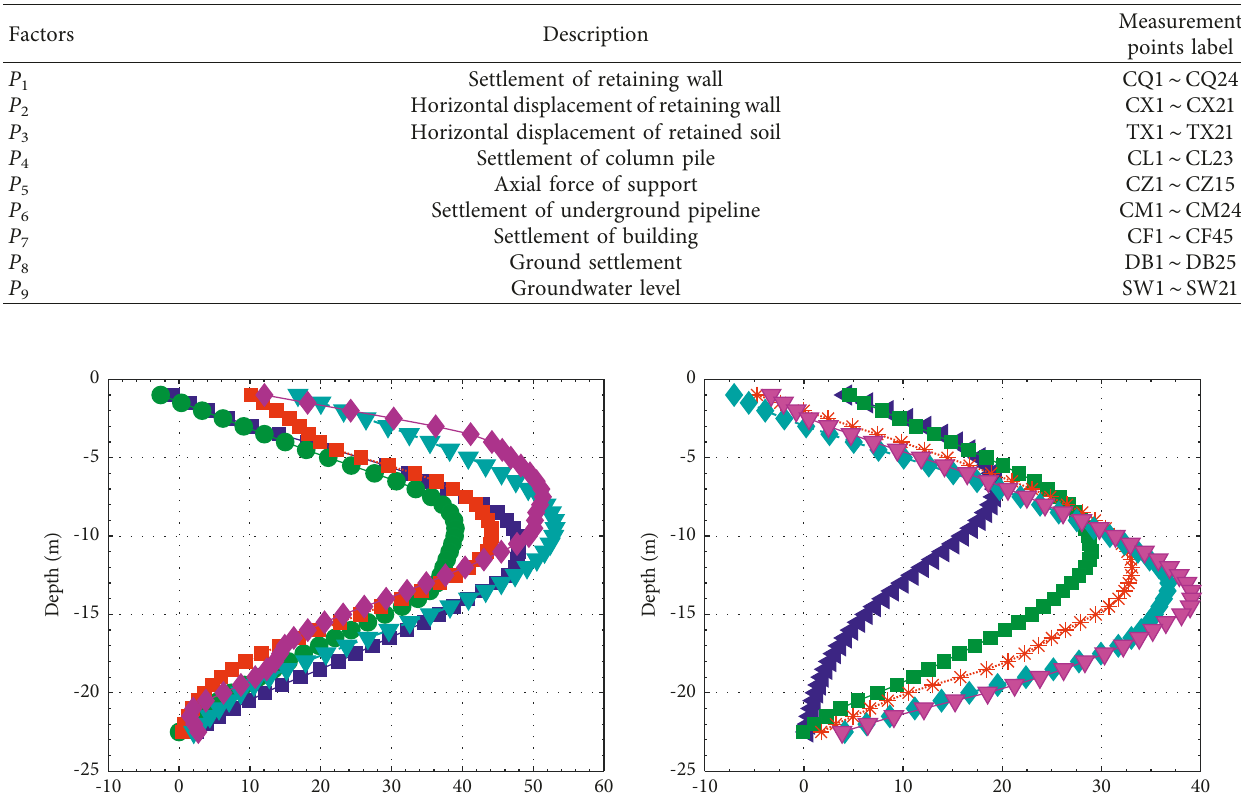
Table 3: Monitoring factors and corresponding measurement points.